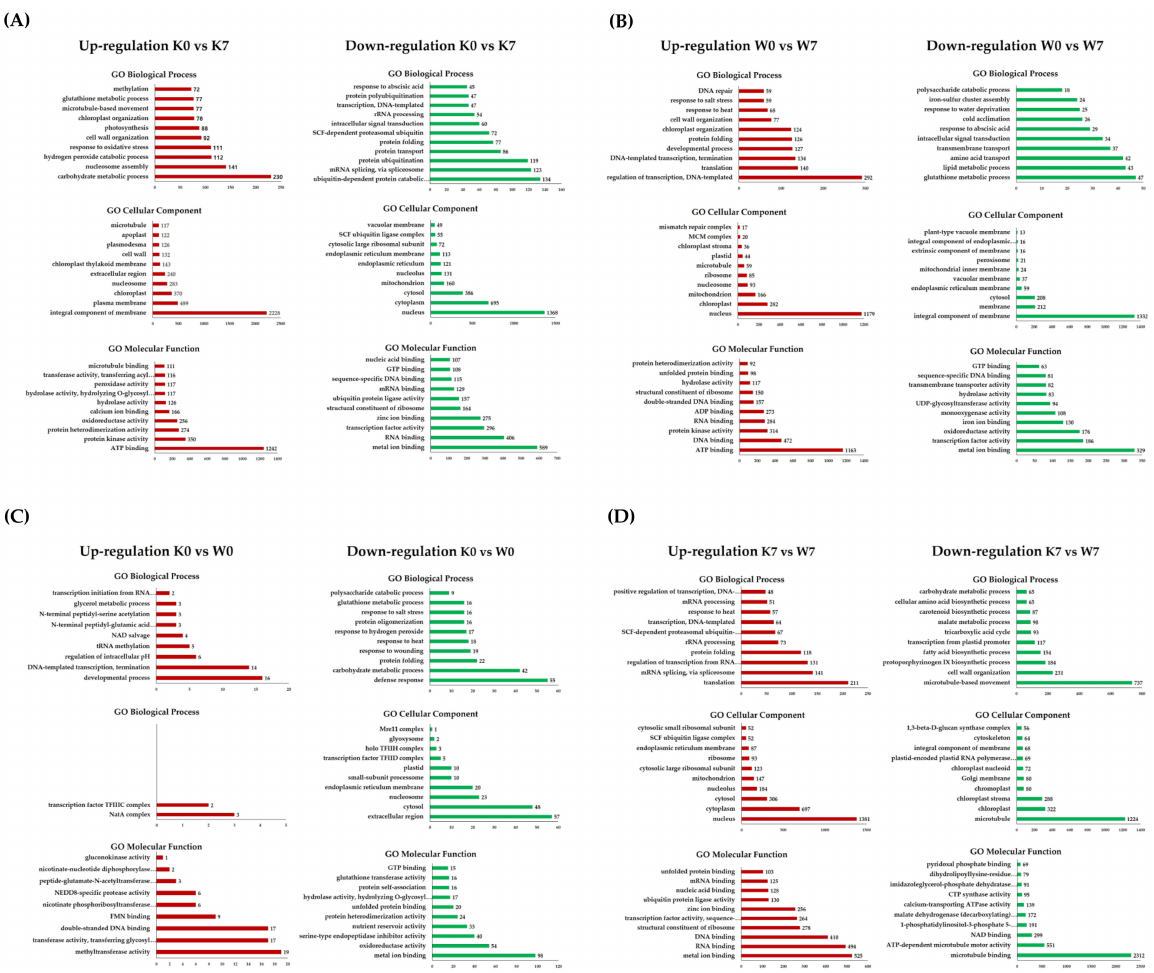
analysis for DEGs in the K0 vs. K7 group, ( F ) heatmap analysis for DEGs in the K0 vs. K7 group, ( G ) heatmap analysis for DEGs in the K0 vs. W0 group, and ( H ) heatmap analysis for DEGs in the K7 vs. W7 group. The X -axis and Y -axis of the scatter plot represent a control group and a case group, respectively, and the value of the axis is the average of the values normalized on a log 2 scale. Red dots indicate more than a doubling of upregulated DEGs, and blue dots indicate more than a doubling of downregulated DEGs. Gray dots indicate no differential expression. The volcano plot is expressed as a p -value derived from the log 2 fold change of the expression value for each comparison group and the average comparison between the two groups. The X -axis represents log 2 fold change; Y -axis represents − log 10 p -value. Heatmap analysis was performed on differentially expressed genes in each comparison group, and the expression was adjusted to p -value < 0.005. Red indicates upregulation and green indicates downregulation.